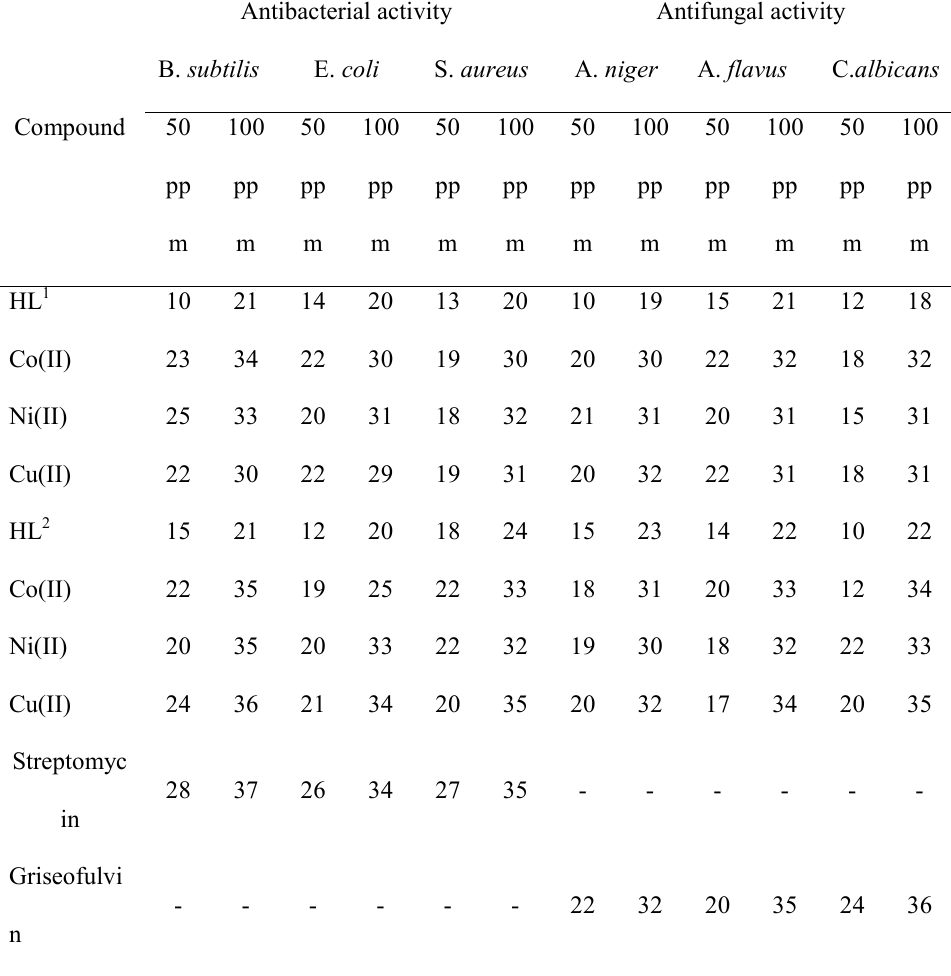
Table 3. In-vitro antibacterial activity of compounds and their inhibition zone (%).